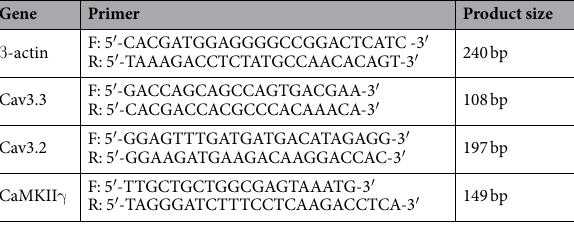
Table 1. CaMKII γ , Cav3.2, Cav3.3 mRNA primer